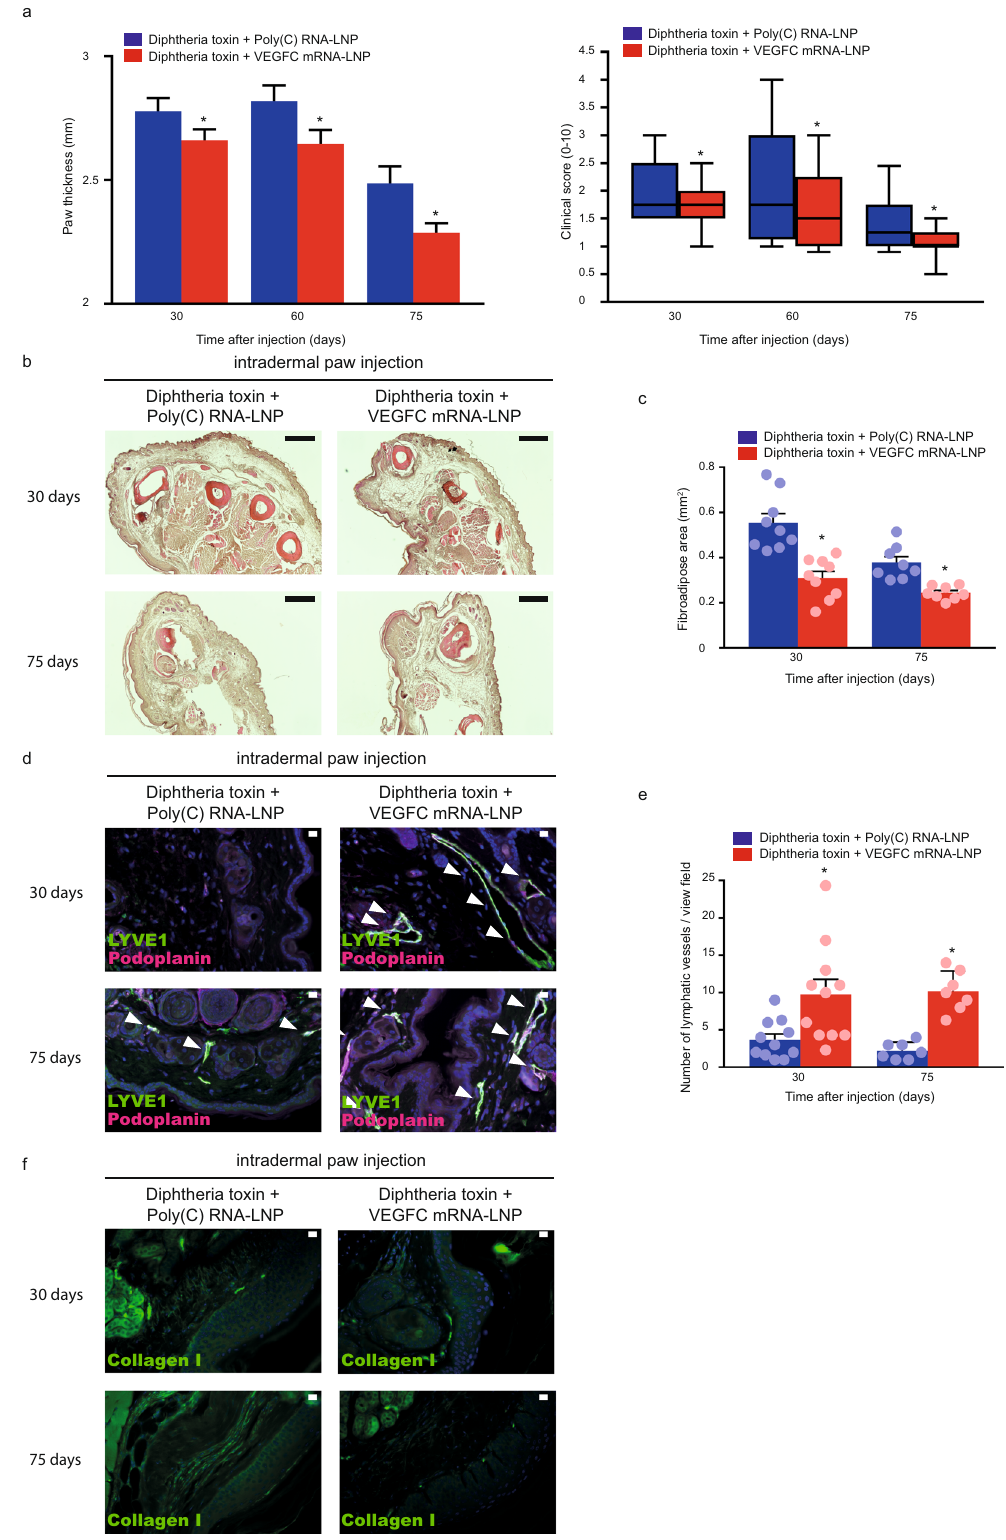
mRNA-LNP injection, ear samples were harvested and digested with Liberase II kit (Roche). In vivo VEGFC expression of the interstitial fl uid of these ear samples was analyzed by Western blot analysis and ELISA. Examples of gating strategy are shown in the Supplementary Information fi le (Supplementary Fig. 8). All investi- gators performing fl ow cytometry were blinded for the sample